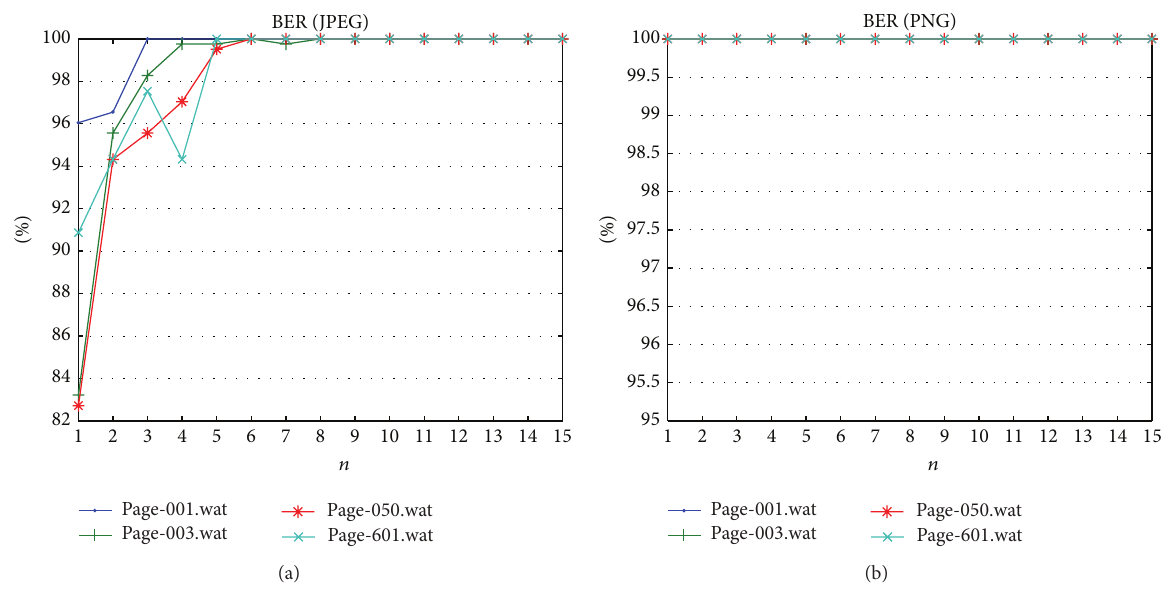
Figure 11: Bit error rate result against Gaussian noise